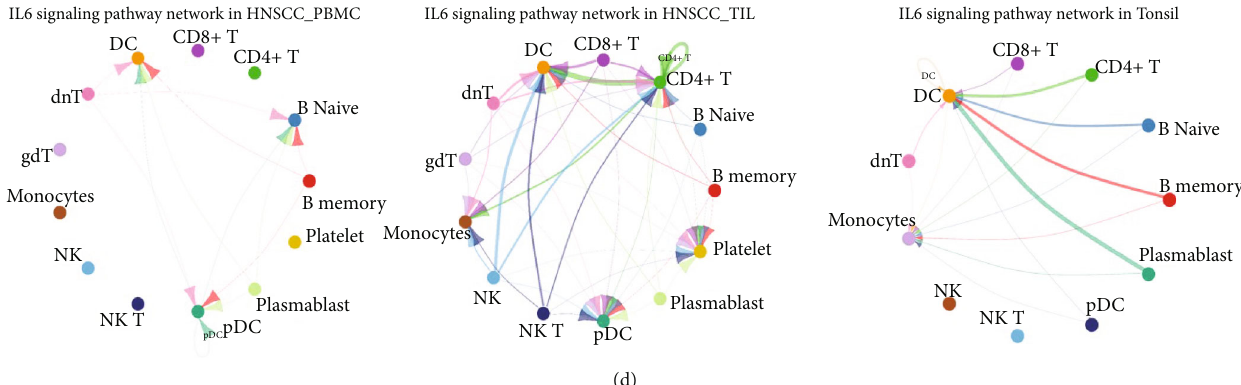
Figure 4: Speci fi c signaling events In the signal pathway network. (a)MHC-I signaling pathway network in HNSCC PBMC, TIL, and tonsil. (b) MHC-II signaling pathway network in HNSC PBMC, TIL, and tonsil. (c) MIF signaling pathway network in HNSC PBMC, TIL, and tonsil. (d) IL6 signaling pathway network in HNSCC PBMC, TIL, and tonsil. The edge color is consistent with the sender ’ s source, and the edge weight is proportional to the interaction strength. A thicker edge line indicates a stronger signal. In the circle chart, the size of the circle is proportional to the number of cells in each cell group.